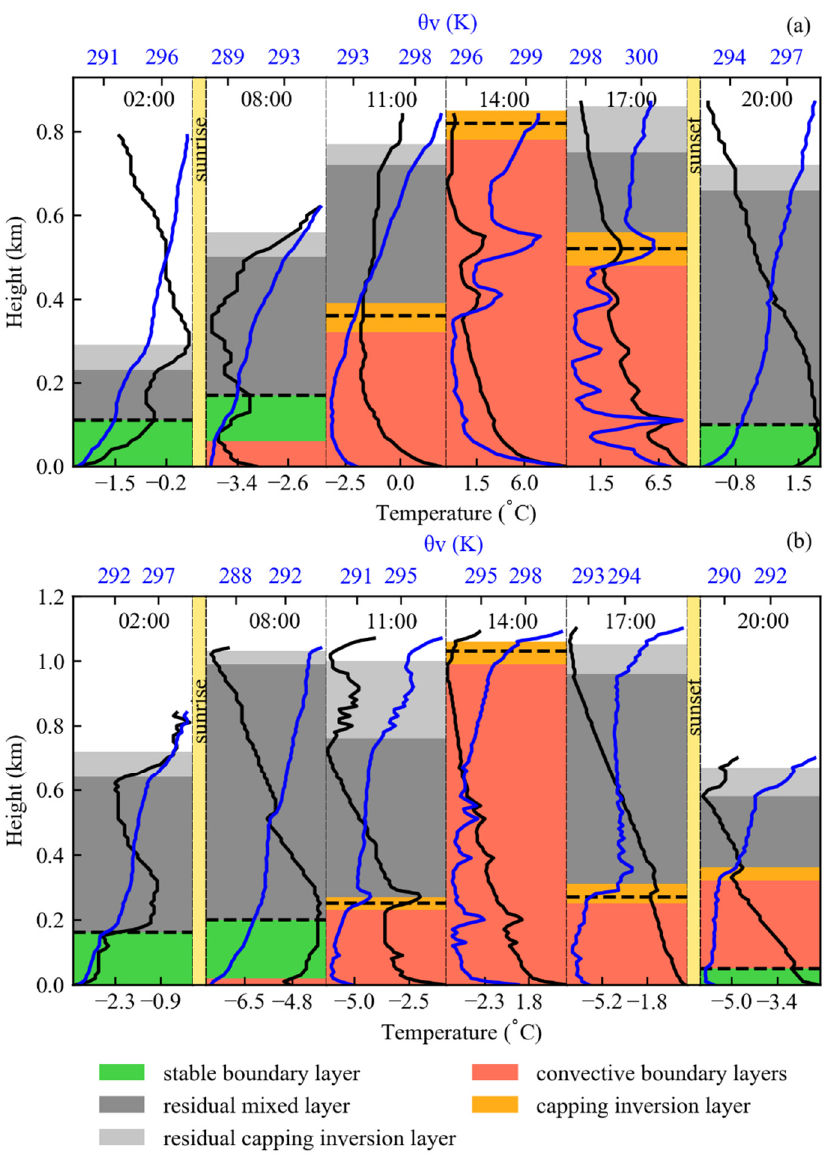
Figure 4. Evolution of the ABL on December ( a ) 12 and ( b ) 24, 2019, determined from TBS data. The stable boundary layer gradually developed upwards with nighttime radiative cooling until sunrise, with tops reaching 170 m on 12 December and 190 m on 24 December, respectively, at 08:00. Residual mixed layers developed more rapidly than stable boundary layers from 02:00 to 08:00. After sunrise, surface-based stable boundary layers were destroyed by solar radiative heating and convective boundary layers began to develop, leading to shallow convective boundary layers at 08:00. As solar radiation continued to intensify, convective boundary layers and capping inversion layers continued to develop, with the latter’s tops reaching 365 m and 242 m, respectively, at 11:00. Convective boundary layers reached maximal heights of 910 m on December 12 and 1050 m on 24 December, respectively, at 14:00 when turbulent mixing was strong. Then, they weakened, with tops decreasing to 528 and 266 m, respectively, at 17:00. Generally, begin to develop. On 12 December at 20:00, the convective boundary layer disappeared, and a stable boundary layer developed at 20:00, but on 24 December at 20:00 the convec- tive boundary layer was maintained (though very weak). Atmospheric boundary layer evolution was properly characterized by the TBS data. The TBS-BLHs on 12